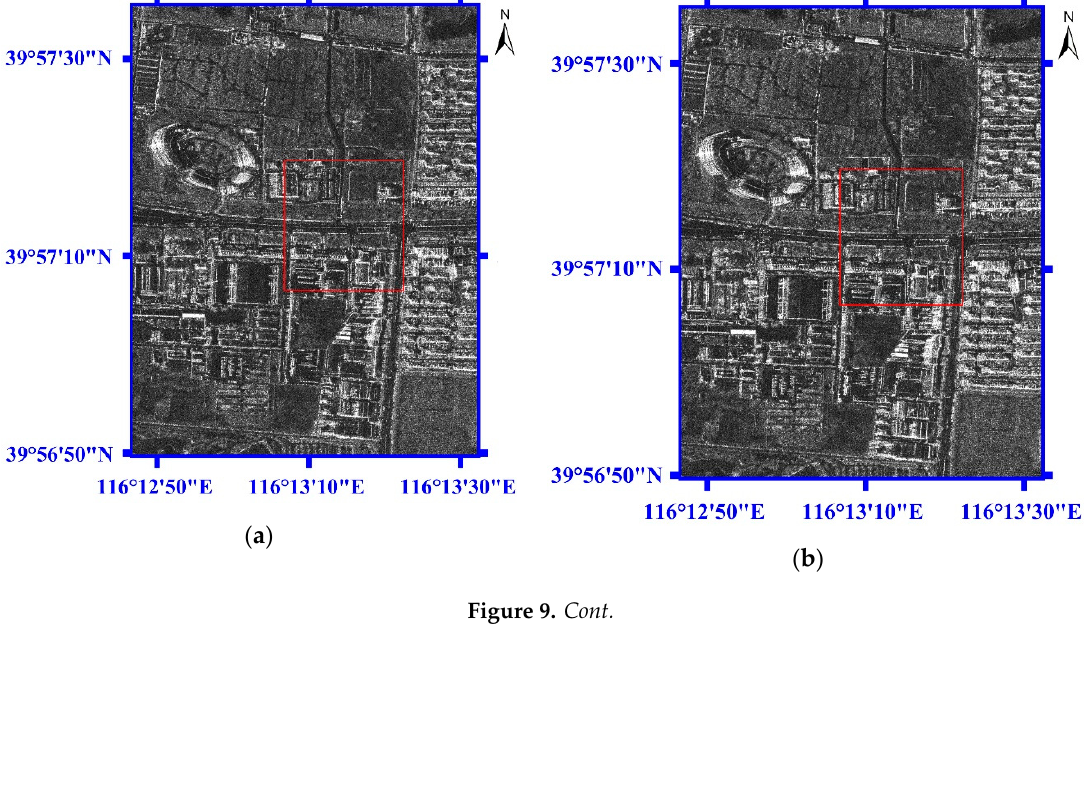
Table 2. The geolocation accuracy for the eight corner